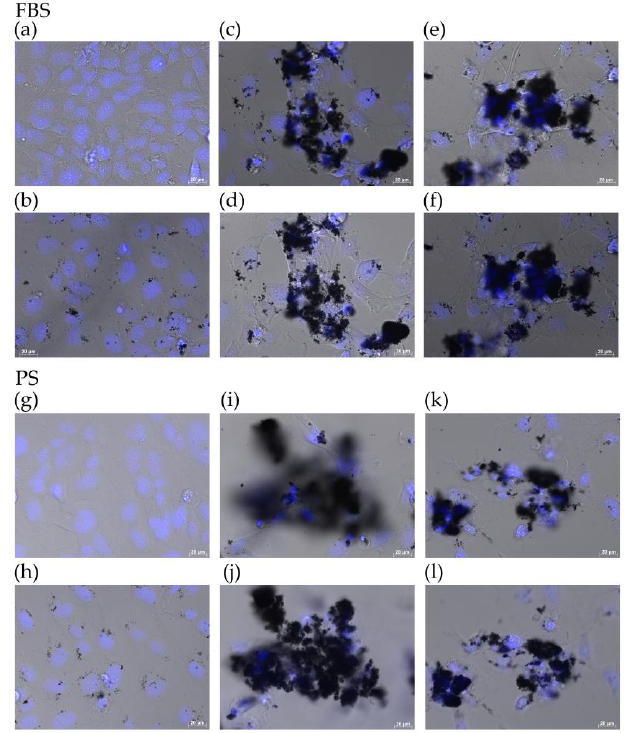
Figure 3. Live cells imaged by differential interference contrast optics after incubation with